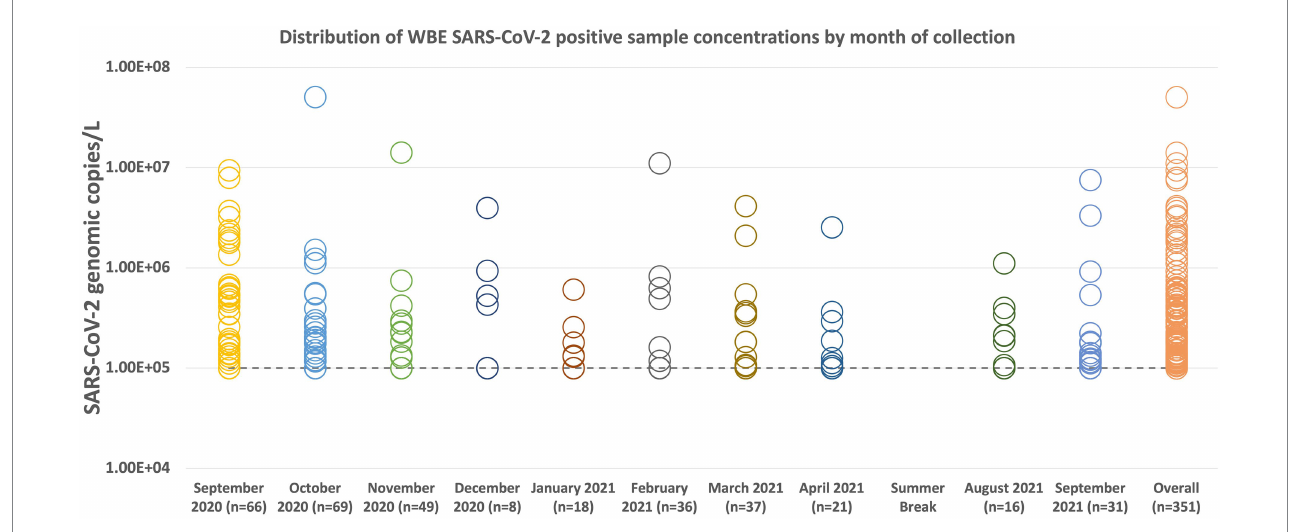
FIGURE 3 Distribution plot of all SARS-CoV-2 positive sample concentrations by collection month. Samples below our limit of quantification of 10 copies/ μ L, but were determined to be positive for the presence of SARS-CoV-2, were labeled as 10 copies/ μ L for presentation purposes. When converted to copies/L, the limit of quantification is 1 × 10 5 copies/L (represented by the dashed line on the graph). The average concentration for the entire group of positive samples (Overall n = 351) is 5.45 × 10 5 genomic copies. Of the 351 positive samples collected, 231 were at or below our limit of quantification. During the summer break of 2021, samples were only collected from three dormitories, the results of which are not displayed